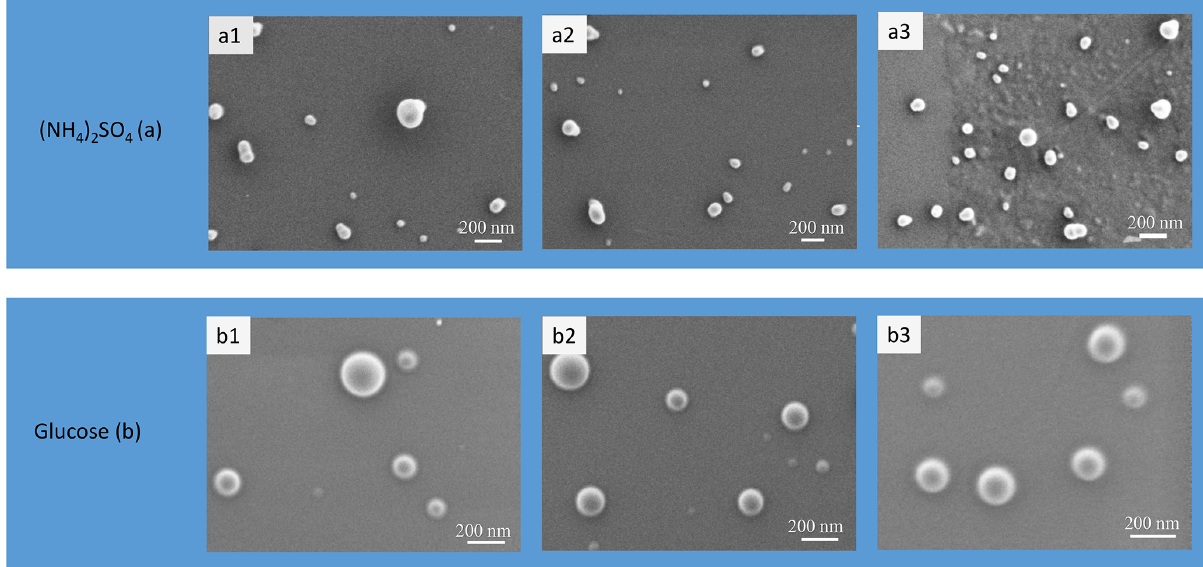
Figure 5. SEM images of initial ammonium sulfate (a) and glucose (b) aerosol particles. The samples were investigated with a high-resolution SEM (Zeiss Merlin). Operation conditions: 0.4kV accelerating voltage, 1.5kV ESB grid voltage, 1.8mm working distance. Particle samples